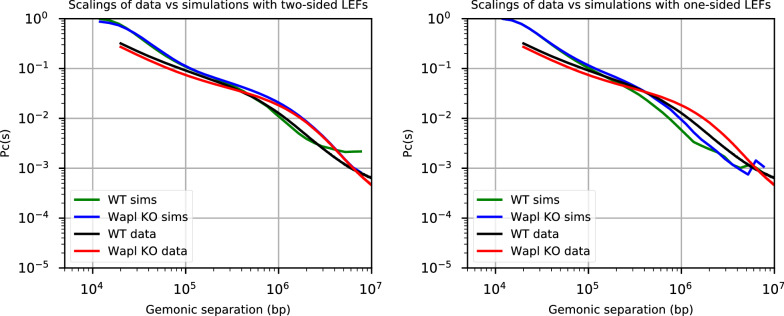
Comparison of the contact probability as a function of genomic separation (scalings) of experiments (Haarhuis et al., 2017) and simulations to validate the chosen parameters for the simulations.We present simulations for two-sided extrusion (left) and one-sided extrusion (right) for both wild-type (WT) and Wapl depletion conditions. With one monomer = 2 kb, λ = d = 200 kb for WT simulations and λ = 2 Mb and d = 200 kb for Wapl depletion simulations. Since the processivity is given by λ = qv/kunbind, with q = 1 or 2 for one- and two-sided LEFs, respectively (see main text), the unbinding rate, kunbind, for one-sided LEFs is chosen to be half that of two-sided LEFs with the same λ. In Figure 3, we used values of λ and d close to their experimental values in WT (Cattoglio et al., 2019; Fudenberg et al., 2016; Holzmann et al., 2019). In Figure 3—figure supplements 4–7 we also consider sweeps of λ and d, including values that match Wapl depletion conditions.